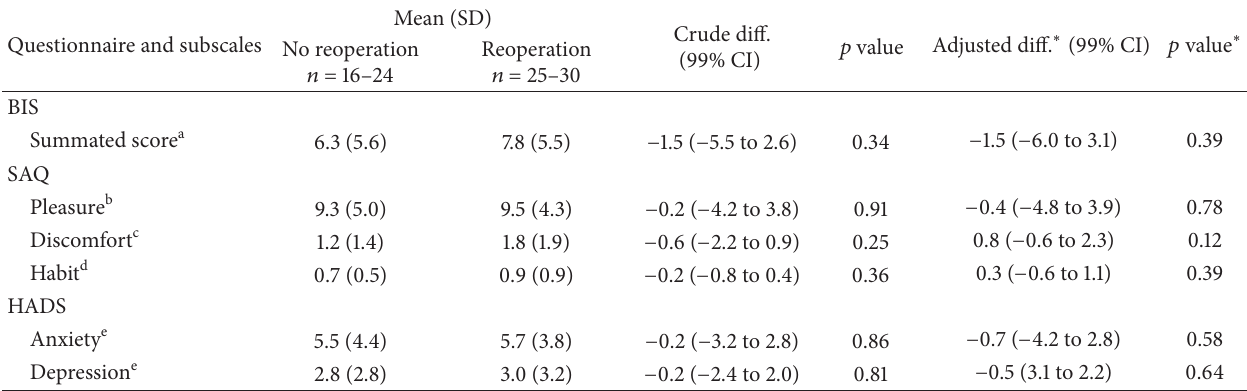
Figure 2: Percentage of patients reporting problems with body image two years after CRRM. ∗ 𝑝 = 0.010 (adjusted for radiotherapy). Table 2: Postoperative scores and standard deviation (SD) for BIS, SAQ, and HADS and differences between the “reoperation group” and the “no reoperation